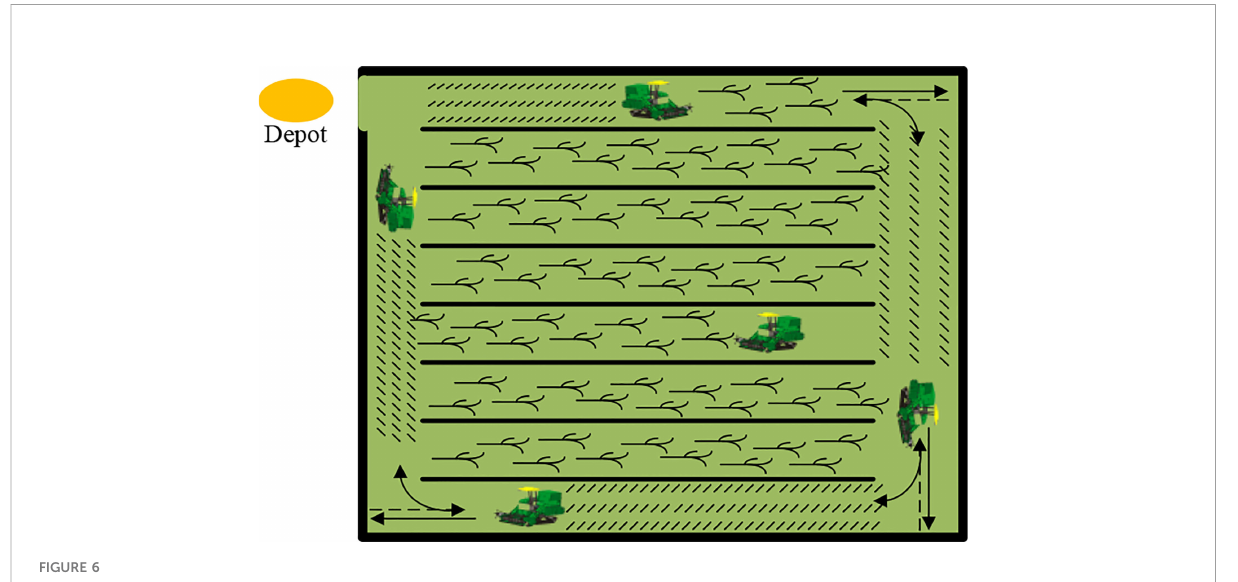
FIGURE 6 Field boundary